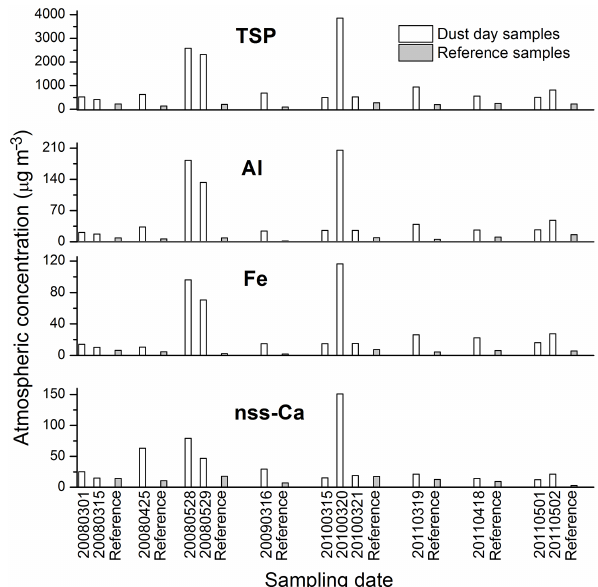
Figure 2. Mass concentrations of TSP, Al, Fe and nss-Ca in aerosol samples collected at the Baguanshan site on dust and reference days during March–May from 2008 to 2011.